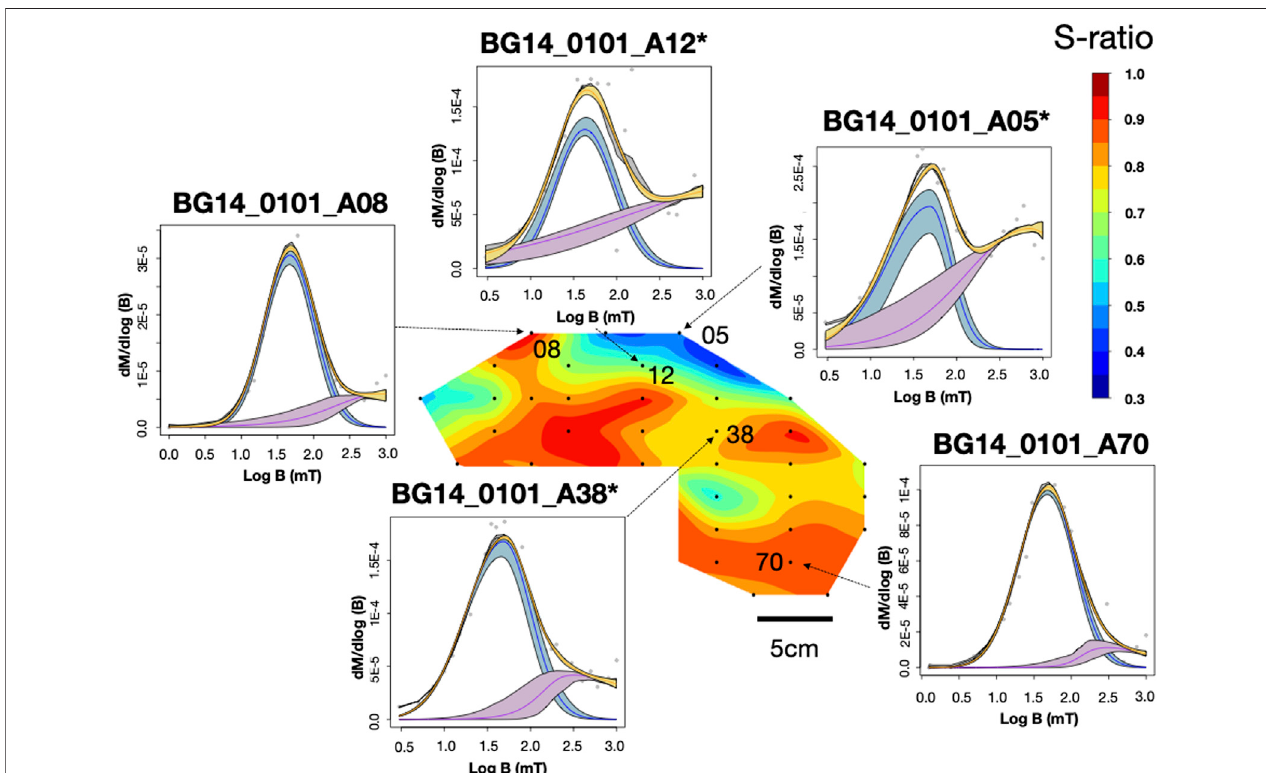
FIGURE5 | IRMunmixingcurveand S-ratio distribution forsample BG14_0101.IRM results wereplotted through the MaxUnmix online software (Maxbauer et al., 2016) on a log scale. Gray dots represent actual data, and yellow lines represent total IRM best- fi t based on real data. Colored lines (blue and purple) represent different coercivity components. The shadings represent 95% con fi dence intervals calculated using a resampling algorithm with N (cid:1) 300. An asterisk next to a specimen name indicates that the specimen went through the -1000mT IRM process.